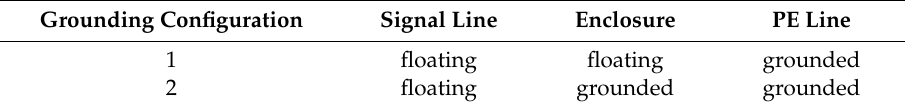
Table 3. The port definition and functions of the ECT acquisition card.